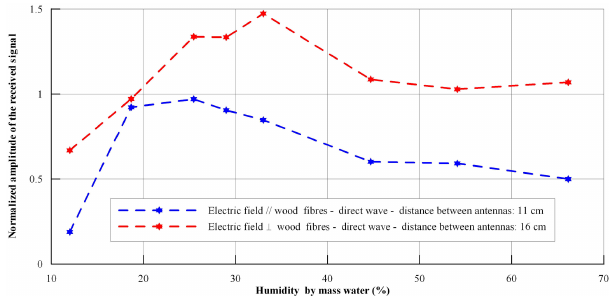
Figure 9. Normalised amplitude of direct wave with respect to hu- midity, for perpendicular and parallel polarisation of the electric